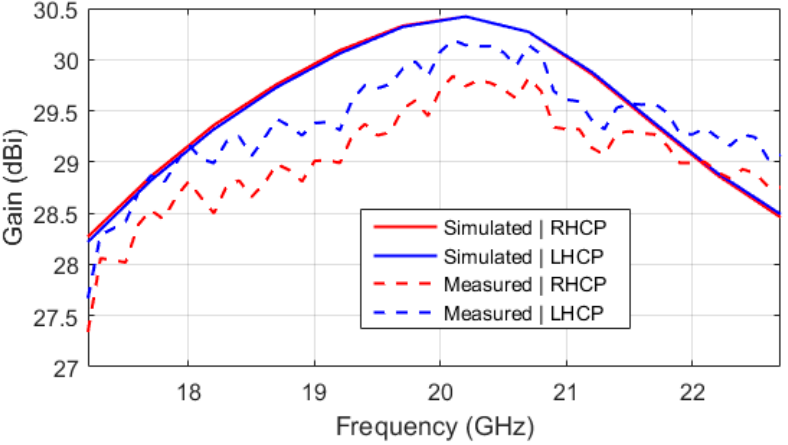
Figure 10. Measured and simulated gain of the reflectarray antenna as a function of frequency.